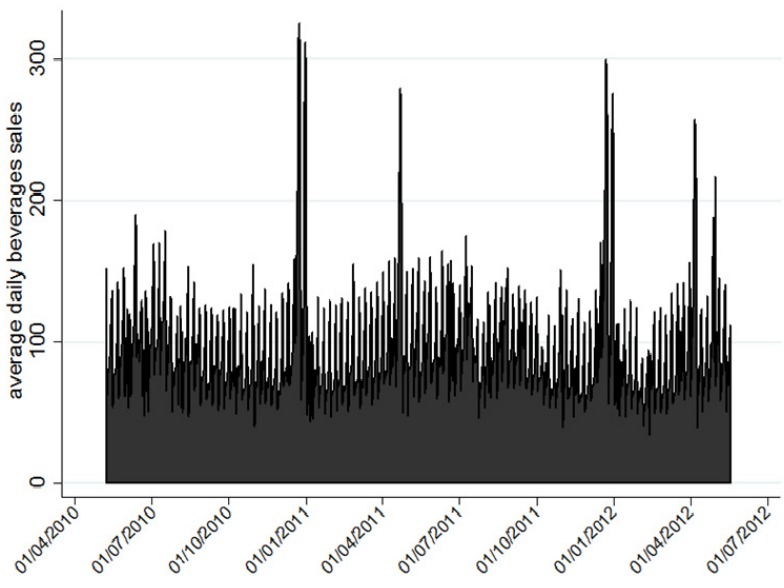
Figure 1. Calendar presentation of non-alcoholic beverage sales.